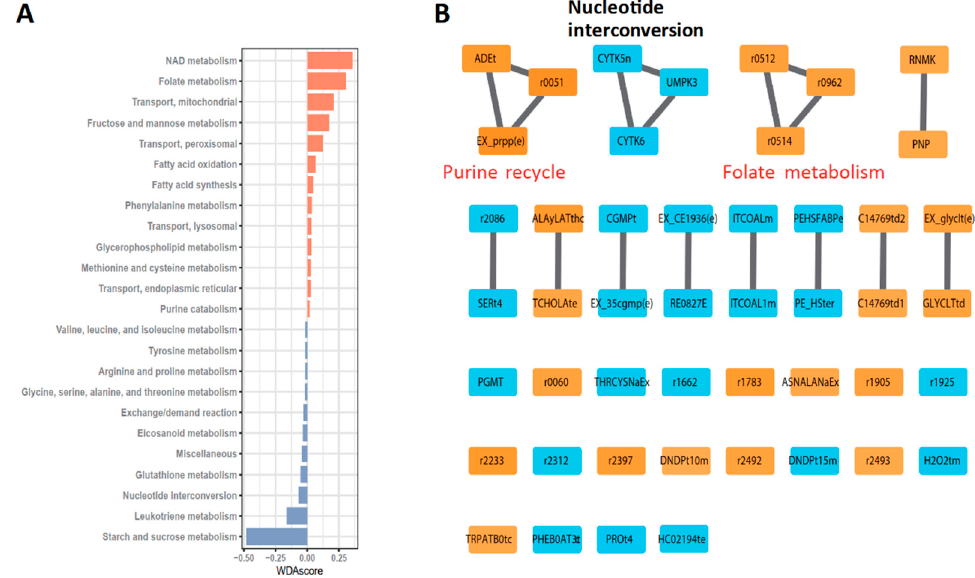
Figure 1. Prognosis analysis of genome − wide precision metabolic modeling in GBM. ( A ): Metabolic pathways correlated with GBM prognosis. Pathways negatively and positively correlated with sur ‐ vival time are colored orange and blue, respectively. ( B ): Metabolic modules associated with GBM prognosis. Modules negatively and positively associated with GBM patient survival time are also colored orange and blue, respectively.